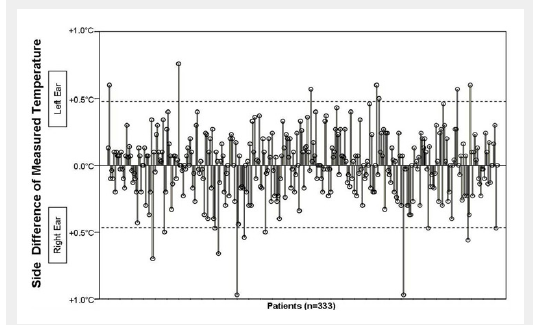
Effect of side of measurement on infrared Ear temperature measurement. Bland-and-Altman plot for comparison of right and left ear measurements. Dotted lines represent the upper and lower limit of the 95% confidence interval of the mean difference.